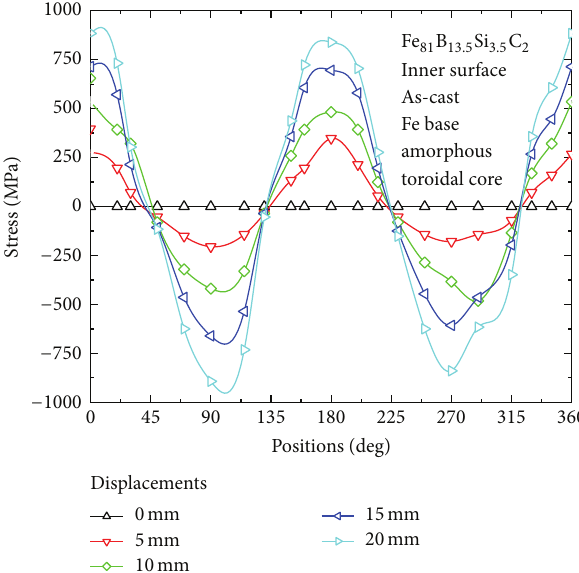
Figure 8: Stress distribution on the inner surface, around the circumference of the as-cast, Fe based, 0.5 mm thick, and 30 mm inner diameter amorphous toroidal transducer